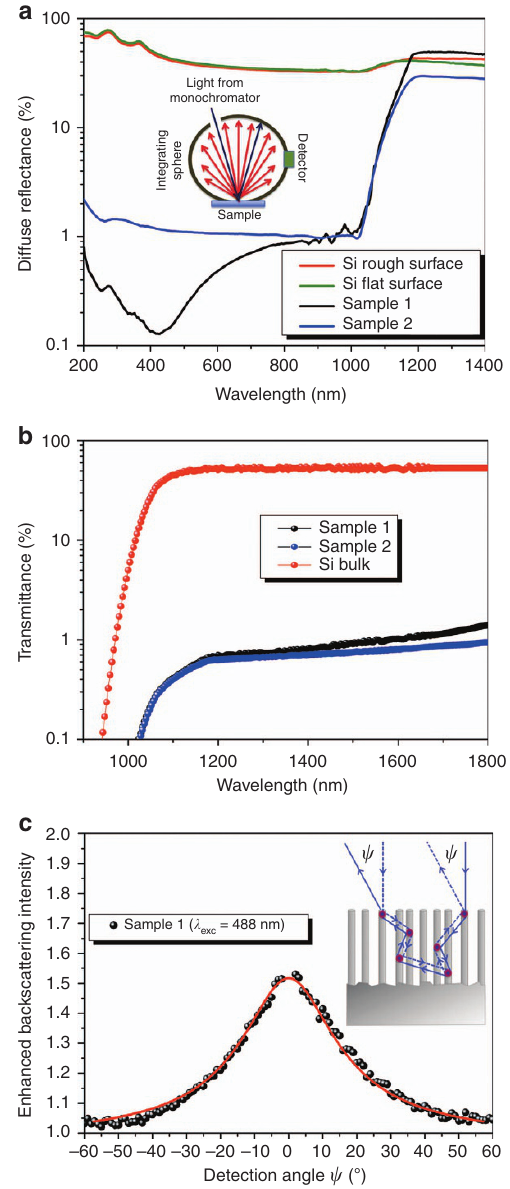
Figure 3 Light-scattering properties of Si NW random fractal array. ( a ) Diffuse (hemispherical) re fl ectance of Si NW sample 1 (black lines) and sample 2 (blue line) and of a bulk c -Si fl at (front) and diffusive rough (back) surface (green and red lines, respectively). ( b ) Direct transmittance, by excluding the diffuse component, of samples 1 and 2 obtained in a polished back surface (black and blue dots, respectively) and of a bulk c -Si (red dots). ( c ) Coherent backscattering cone (black dots) of sample 1 obtained at an excitation wavelength of 488 nm; the red continuous line is the best- fi tting curve obtained by the semi-in fi nite slab model. The inset shows a schematic sketch of the